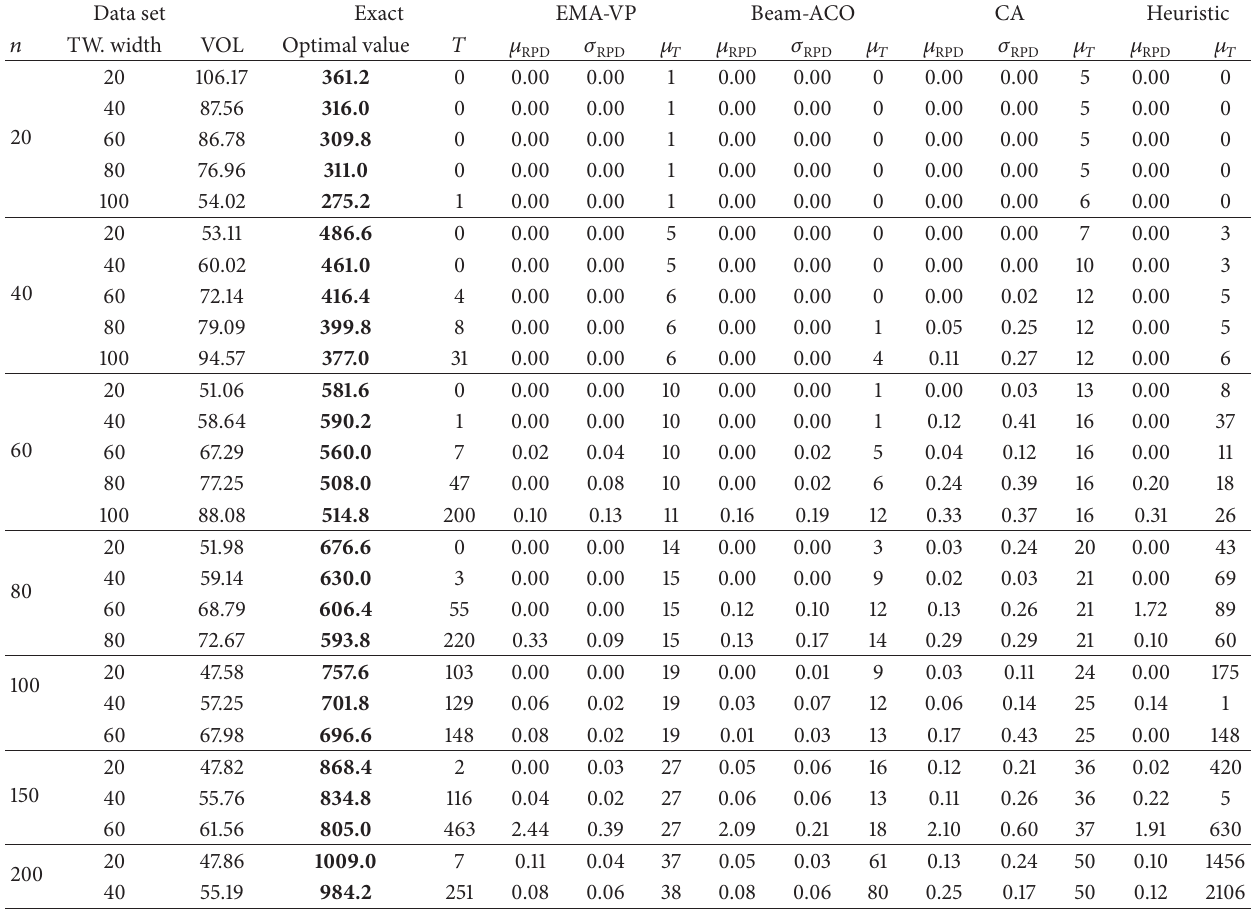
Table 6: Computational results on benchmark set 3.